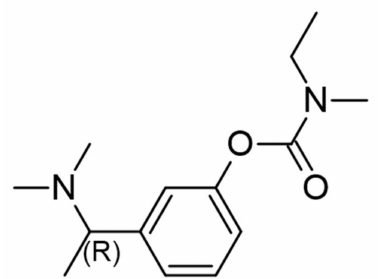
Figure 2. Chemical structure of